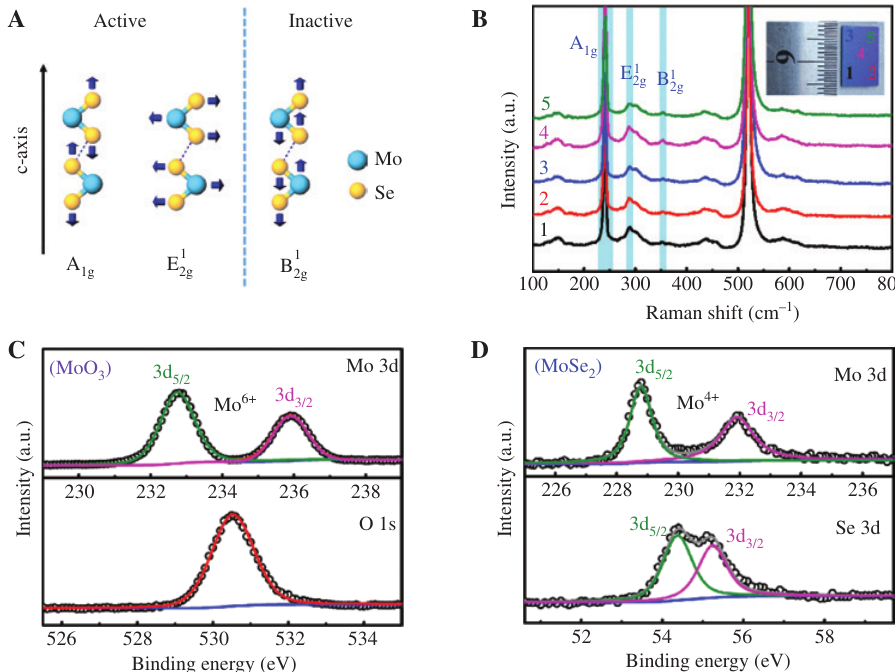
Figure 4: Structural and compositional investigations of the as-grown samples. (A) Schematic representation of two Raman active and one inactive vibration modes in 2H-MoSe mode. Blue and yellow balls represent Mo and Se atoms, respectively. (B) Raman spectra taken from the as-synthesized few-layer MoSe five measurement points (inset). (C) High-resolution XPS spectra of MoO (D) XPS measurements for the Mo 3d and Se 3d core levels of the synthesized MoSe